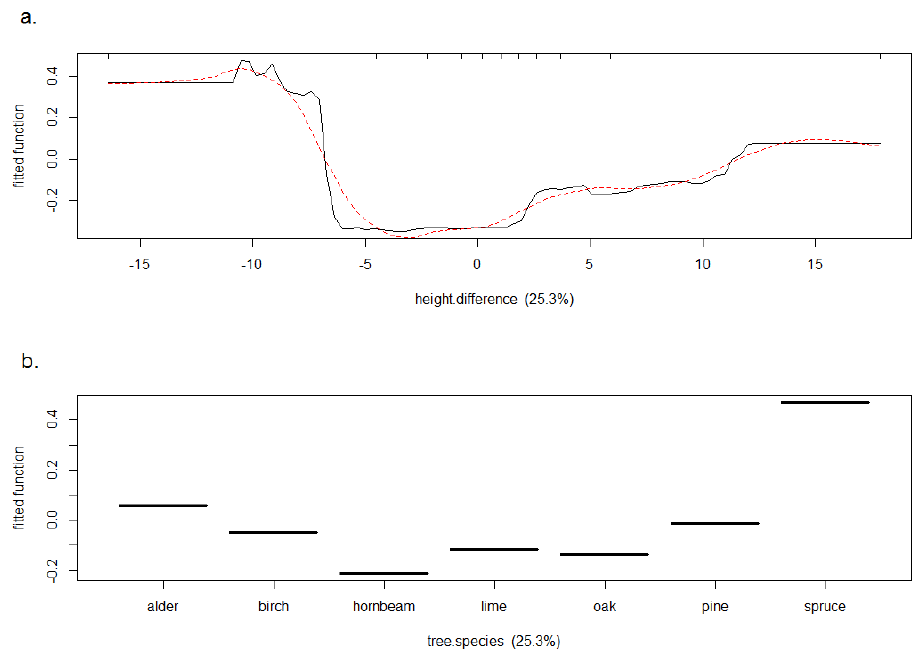
Figure 5. Partial dependency plots for the BRT model illustrating the relationship between the absolute value of the di ff erence between the ALS and DAP heights and the height di ff erence ( a ) and tree species ( b ). Percentages represent the relative contributions of the predictors to the BRT model. The fitted function (y-axis) shows the e ff ect of the predictors on the absolute value of the di ff erence between the ALS and DAP heights after all other predictors are averaged. The tick marks represent a 10th percentile of the data.